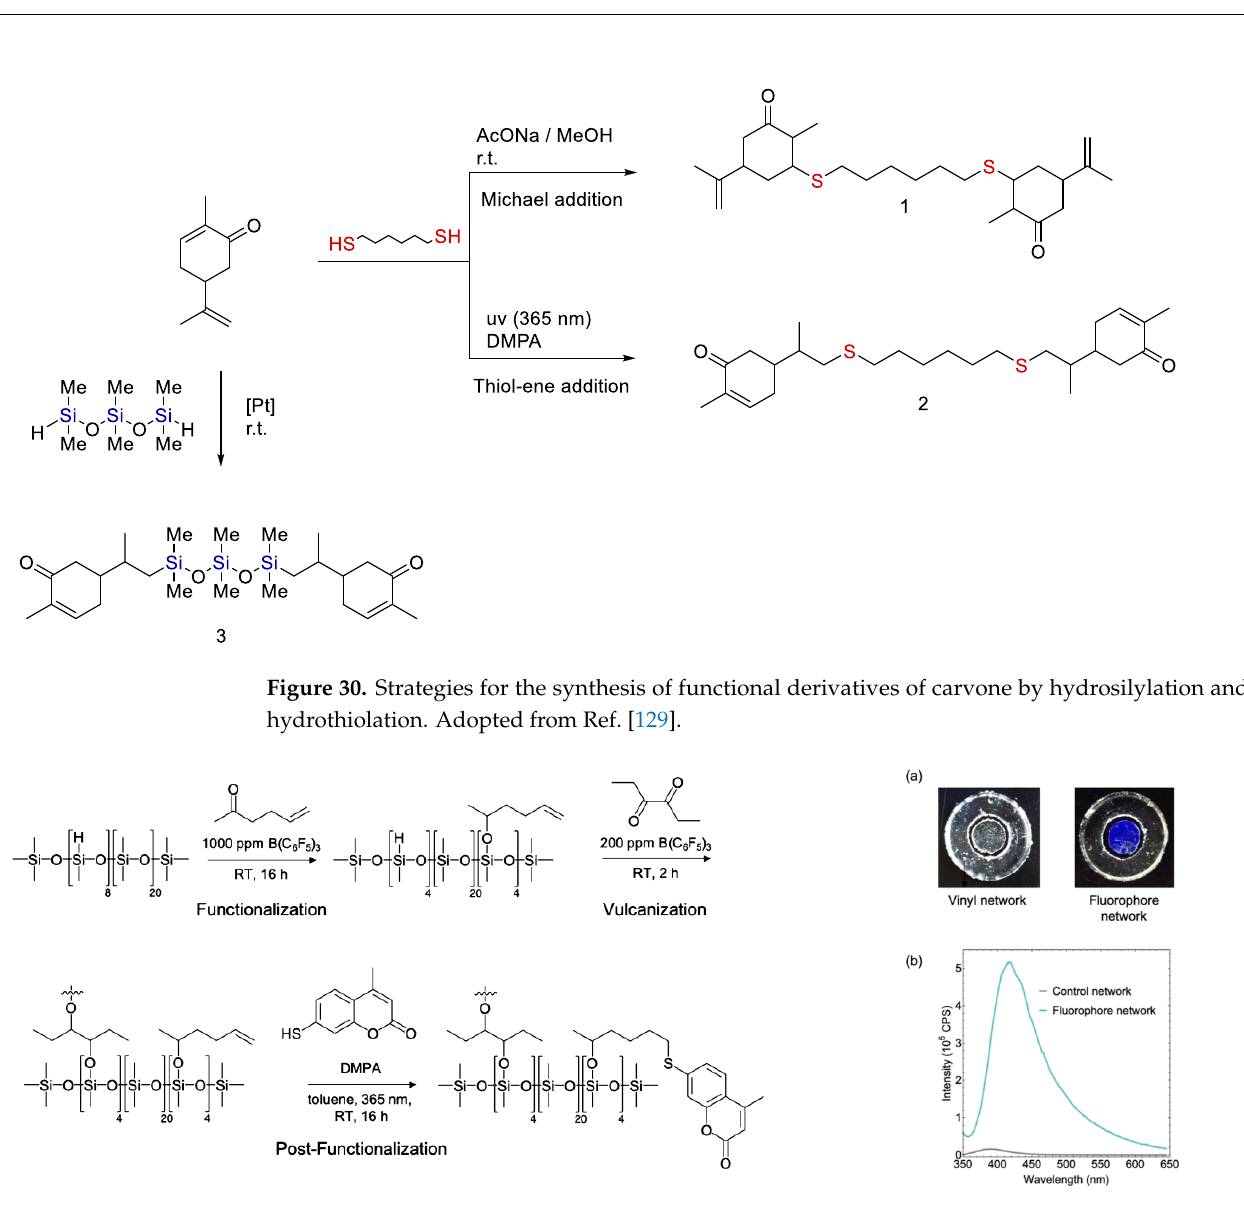
Figure 31. A scheme for synthesizing a cross-linked silicone by hydrosilylation involving a diketone followed by hydrothiolation with a thiol-containing coumarin dye. Reprinted/adapted with permission from Ref. [130]. (a) Images of the vinyl-functionalized network before (left) and after (right) thiol−ene click with 7 -mercapto-4- ethylcoumarin under 365 nm irradiation. Center disk has undergone thi ol−ene click, while the outer ring is an unreacted control sample. (b) Fluo- rescence spectra of the coumarin-containing network as well as the undecorated control.